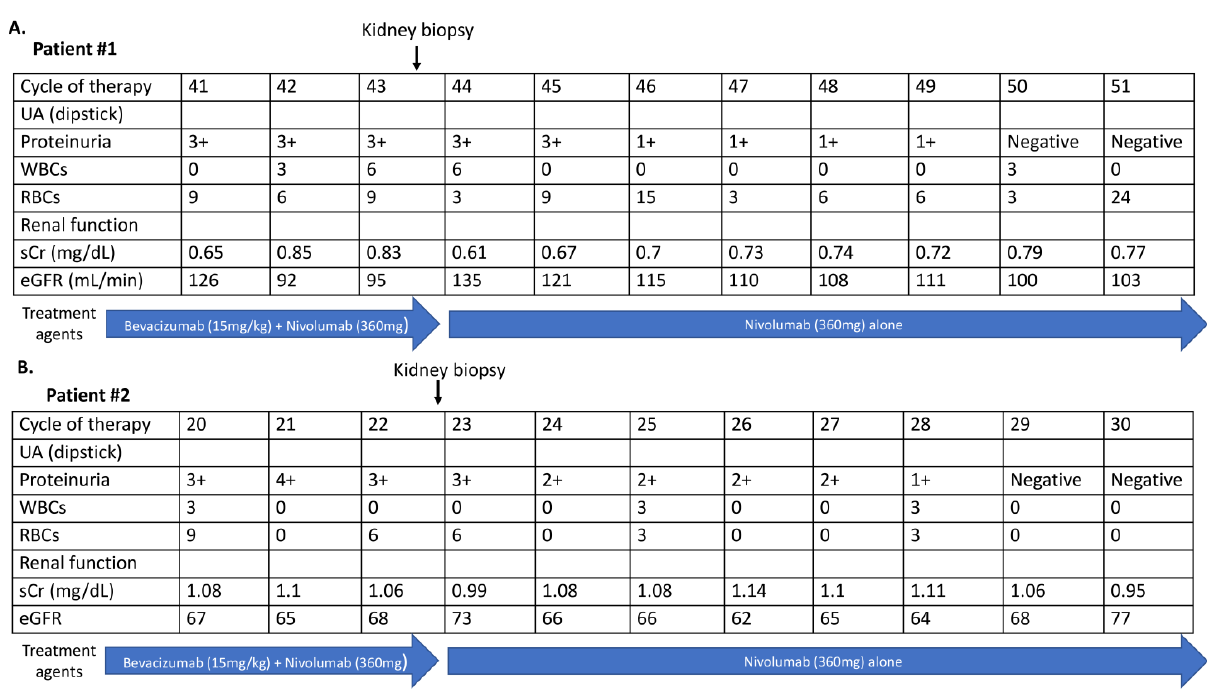
Figure 2. Kidney biopsy pathological findings for the 2 patients. ( A , D ) Light microscopy showing fibrin thrombi and tactoids (green arrows) in the glomerular capillary. ( B , C , F ) Electron microscopy showing glomerular injury with fibrin thrombi and tactoids (yellow arrows), and ( E ) double-contoured appearance of the newly formed basement membrane (red arrows). The biopsy pathological findings confirmed the diagnosis of thrombotic microangiopathy (TMA).